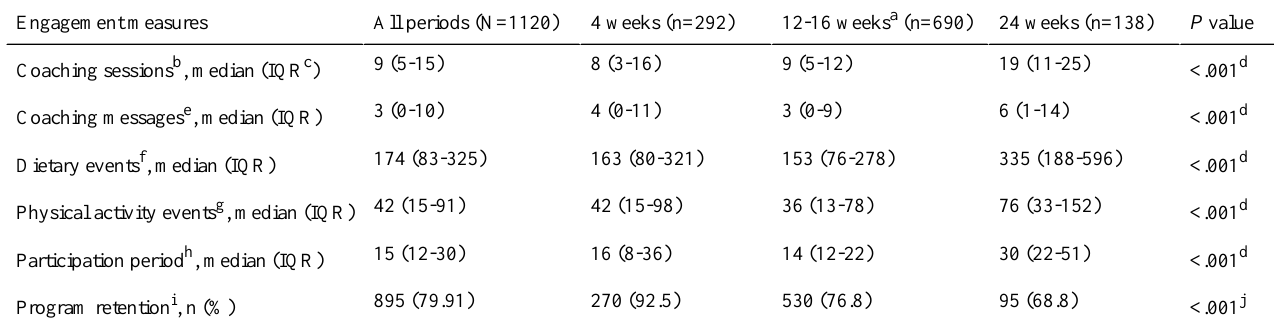
Table 2. Engagement of participants with mobile app–based program by commitment period, among all participants (N=1120).